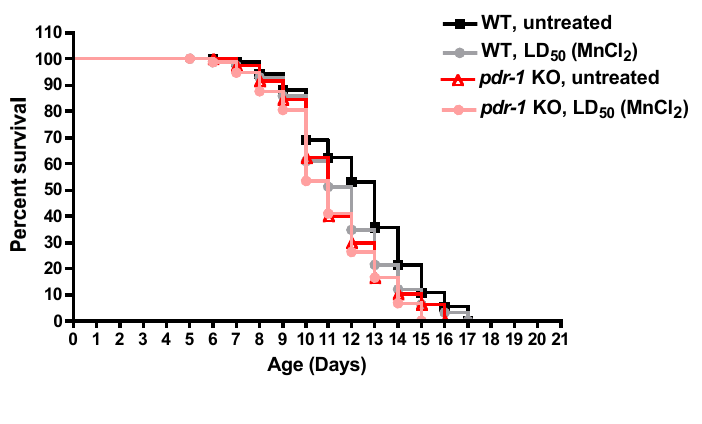
Figure 2. Decreased lifespan in pdr-1 KO worms is exacerbated by Mn exposure. Two thousand five hundred L1 worms were treated with MnCl for 30 min, washed and then 2 plated onto NGM plates spread with OP50 bacteria. Twenty worms were plated in triplicates per group. Worms were assessed for survival each day, and transferred to fresh plates every other day, until all worms had died. Wildtype worms: N2 strain; pdr-1 KO: pdr-1 ( gk448 ) deletion. Compared to untreated WT animals, the other groups show a statistically significant leftward shift in lifespan (logrank test, p < 0.001), with one-way ANOVA analysis on median survival finding a significantly decreased lifespan in treated WT worms ( p < 0.001) that is enhanced in the pdr-1 KO animals ( p <